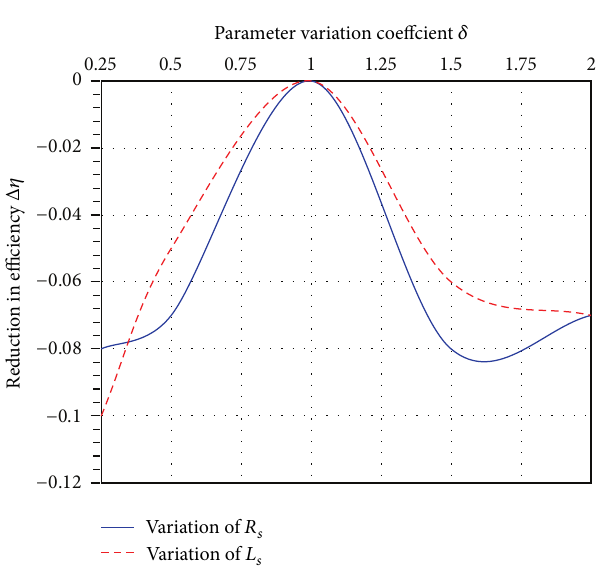
Figure 15: Effect of parametric variations on the efficiency of PMSM for rated speed and rated